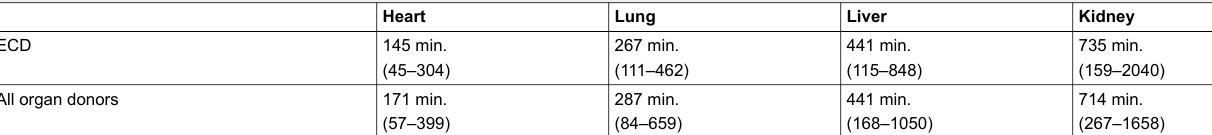
Table 2: Comparison between mean CIT of ECD and of all organ donors (ECD and